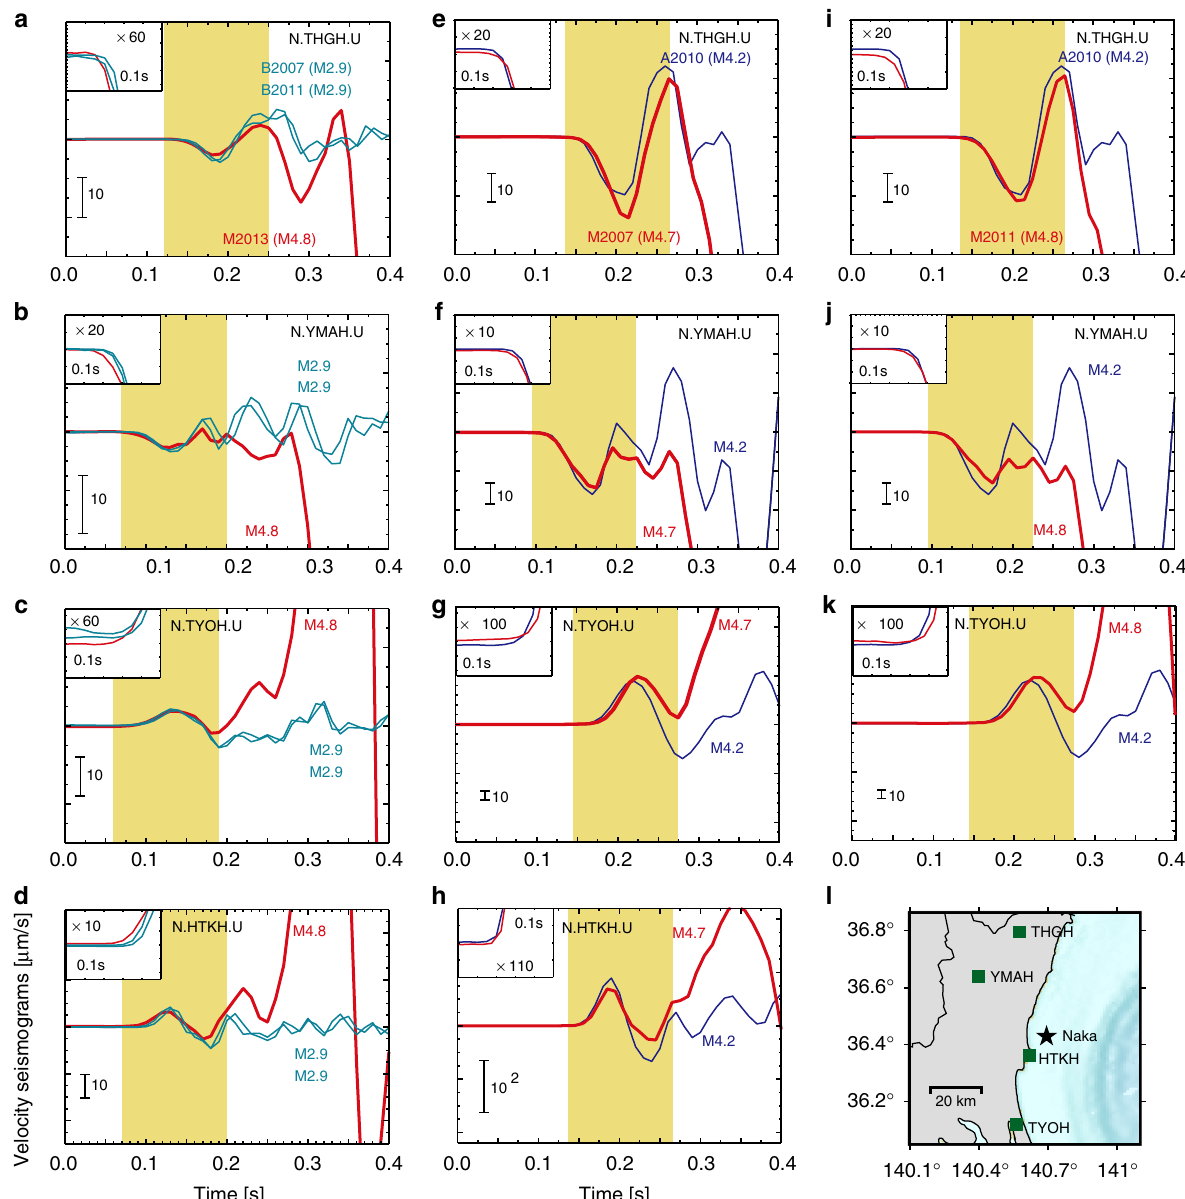
Fig. 3 Seismogram comparison between the mainshocks and the smaller earthquakes. Waveform comparison between M2013 ( M 4.8), B2007 ( M 2.9), and B2011b ( M 2.9) at each station: a N.THGH. b N.YMAH. c N.TYOH. d N.HTKH. Waveform comparison between M2007 ( M 4.7) and A2010 ( M 4.2) at each station: e N.THGH. f N.YMAH. g N.TYOH. h N.HTKH. Waveform comparison between M2011 ( M 4.8) and A2010 ( M 4.2) at each station: i N.THGH. j N. YMAH. k N.TYOH. The vertical components of the seismograms are shown, with the onset of the P-waves magni fi ed in the inset. The yellow zones